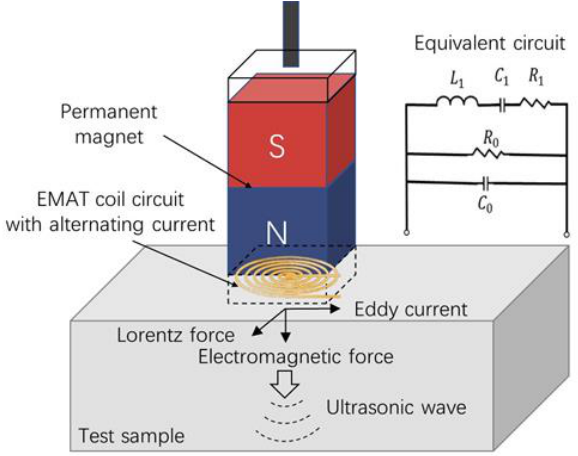
Figure 2. The configuration and equivalent circuit of an EMAT.